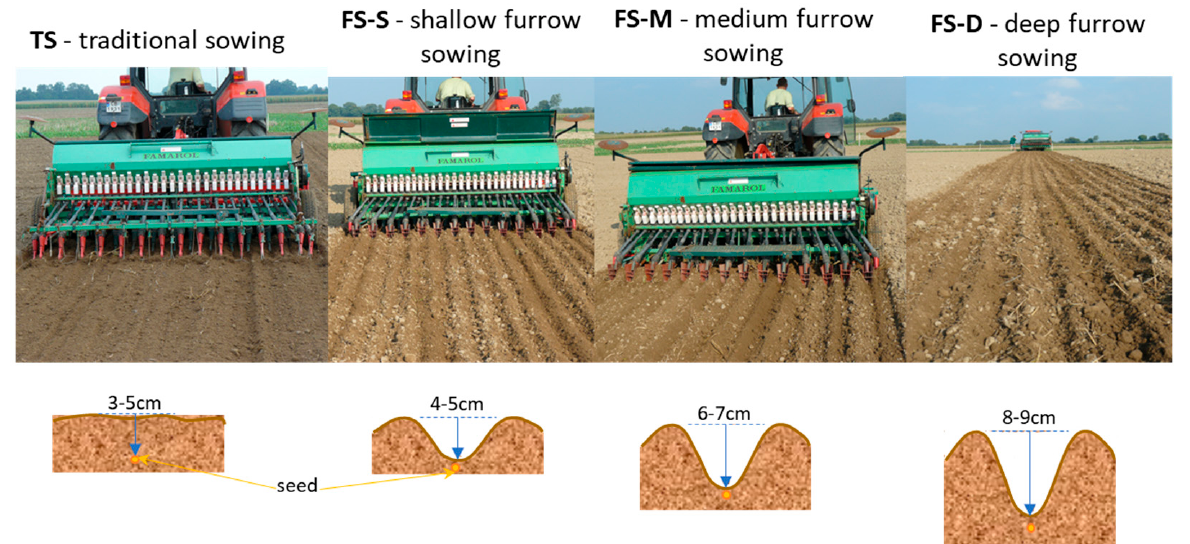
Figure 2. Sowing method and depth. Factor II—plant species grown in catch crop: field pea; spring